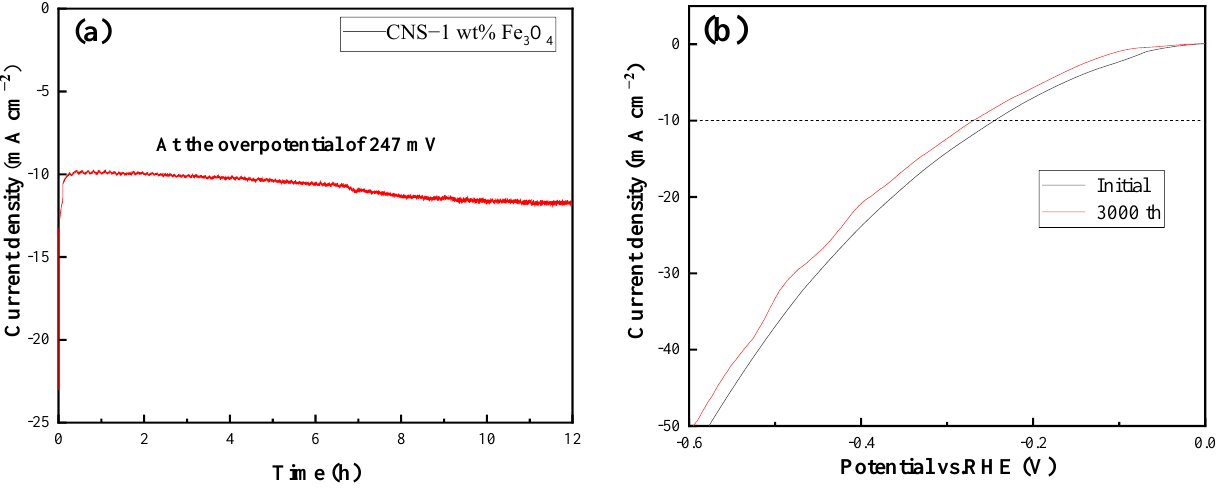
Figure 9. ( a ) Chronoamperometric responses at the overpotential of 247 mV, ( b ) HER polarization curves of the Fe 3 O 4 /CNS electrode before and after 3000 CV.